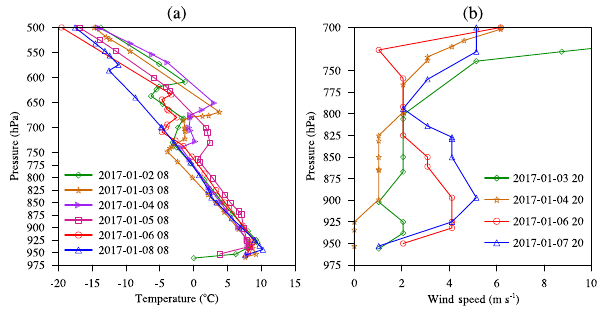
Figure 6. Vertical profiles of (a) temperature and (b) horizontal wind speed at Wenjiang station (30.75 ◦ N, 103.875 ◦ E; see Fig. 1) measured by a radiosonde during event